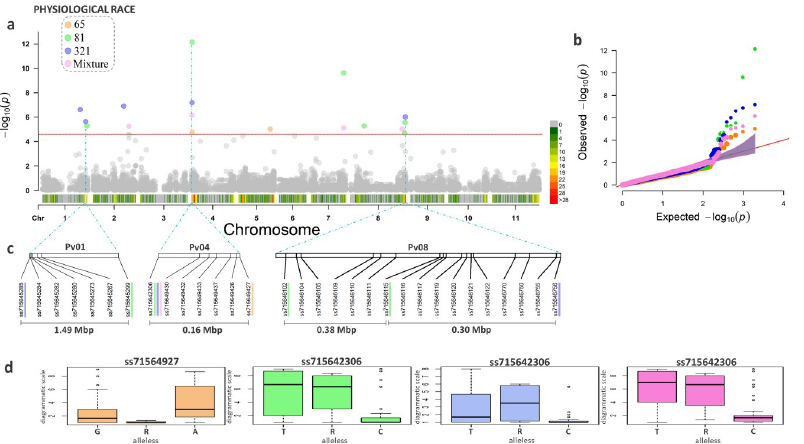
Fig 2. Genome-wide association study analysis for resistance to multiple races of anthracnose with 1,942 high- quality simple nucleotide polymorphisms (SNPs) genotyped in the carioca diversity panel (CDP). (a) Manhattan plots showing the association between the SNP markers and the physiological races of C . lindemuthianum . Each color corresponds to a different race, with the colors orange, green, blue, and pink corresponding to races 65, 81, 321, and admixture, respectively; (b) QQ-plot for the races evaluated; (c) Position of significant SNPs in genomic regions with SNPs associated with more than one race, showing the distance between them; (d) Boxplots illustrating the relationships between alleles and phenotypes for the significant SNPs located at the beginning of the Pv04 chromosome and associated with all the races tested.